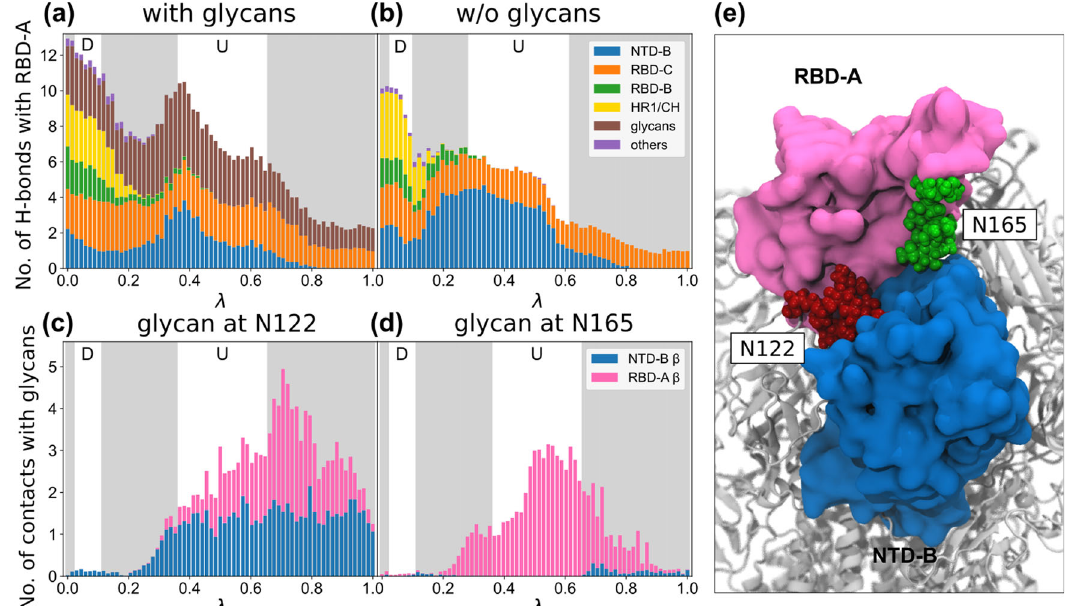
Fig. 4 Hydrogen bond and contact analysis reveals the different interaction patterns with and without glycans. a , b Along the MEPs as indicated by the path parameter λ (see Fig. S2), the number of hydrogen bonds formed between the opening RBD-A and the rest of the spike are counted and classi fi ed by domain for the a glycosylated and the b un-glycosylated systems. The locations of the down- and up-state energy wells are shown with white backgrounds while other regions are shaded in grey. c , d The average number of contacts for the glycosylated system formed between the glycans at c N122 and d N165 and the neighboring β -strand from NTD-B (165 – 172) and RBD-A (353 – 360), which would otherwise form hydrogen bonds with each other if not separated by the glycans. e Snapshot from the REUS simulation showing the glycans at N165 and N122 disrupting hydrogen bond formation between RBD-A and NTD-B, destabilizing the up state compared to the un-glycosylated